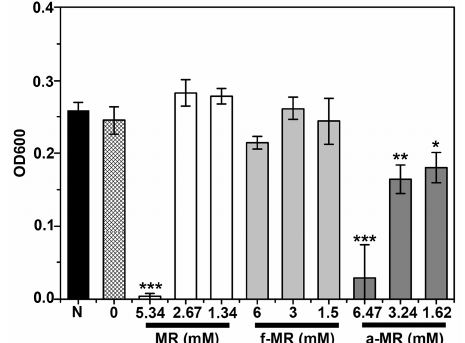
Figure 8. Effects of outer membrane permeabilization agents on the antibacterial activity of peptides are shown. The “0” mark represents the group with 0.05 mM EDTA and 0.35 mM Tris, but without peptides, while the “N” mark represents the group without the agent and peptides as the negative group. The rest of the group was mixed with 0.05 mM EDTA and 0.35 mM Tris, as well as peptides at the different concentrations. Results are the mean values ± SD of three independent experiments. * α < 0.05, ** α < 0.01, *** α < 0.001 vs. control.